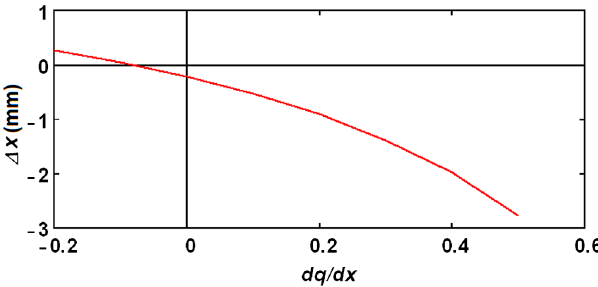
FIG. 11. Dependence of shift of the impact point after each flight on the derivative dq=dx .